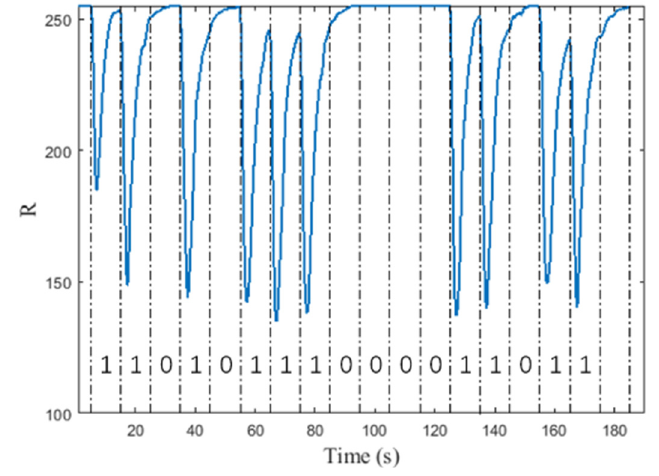
Figure 4. Example of communication.